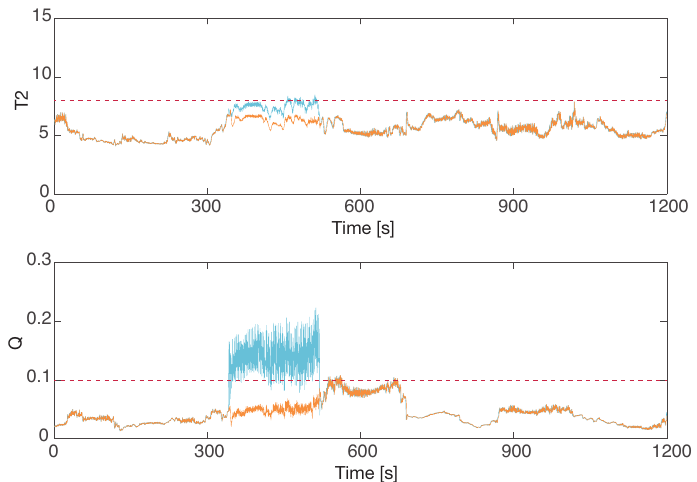
Figure 15. The epileptic prediction result of an interictal episode by the T 2 ( top ) and Q ( bottom ) statistics: the original RRI data (blue) and modified RRI data (red). The false positive caused by PVC was successfully suppressed using the proposed